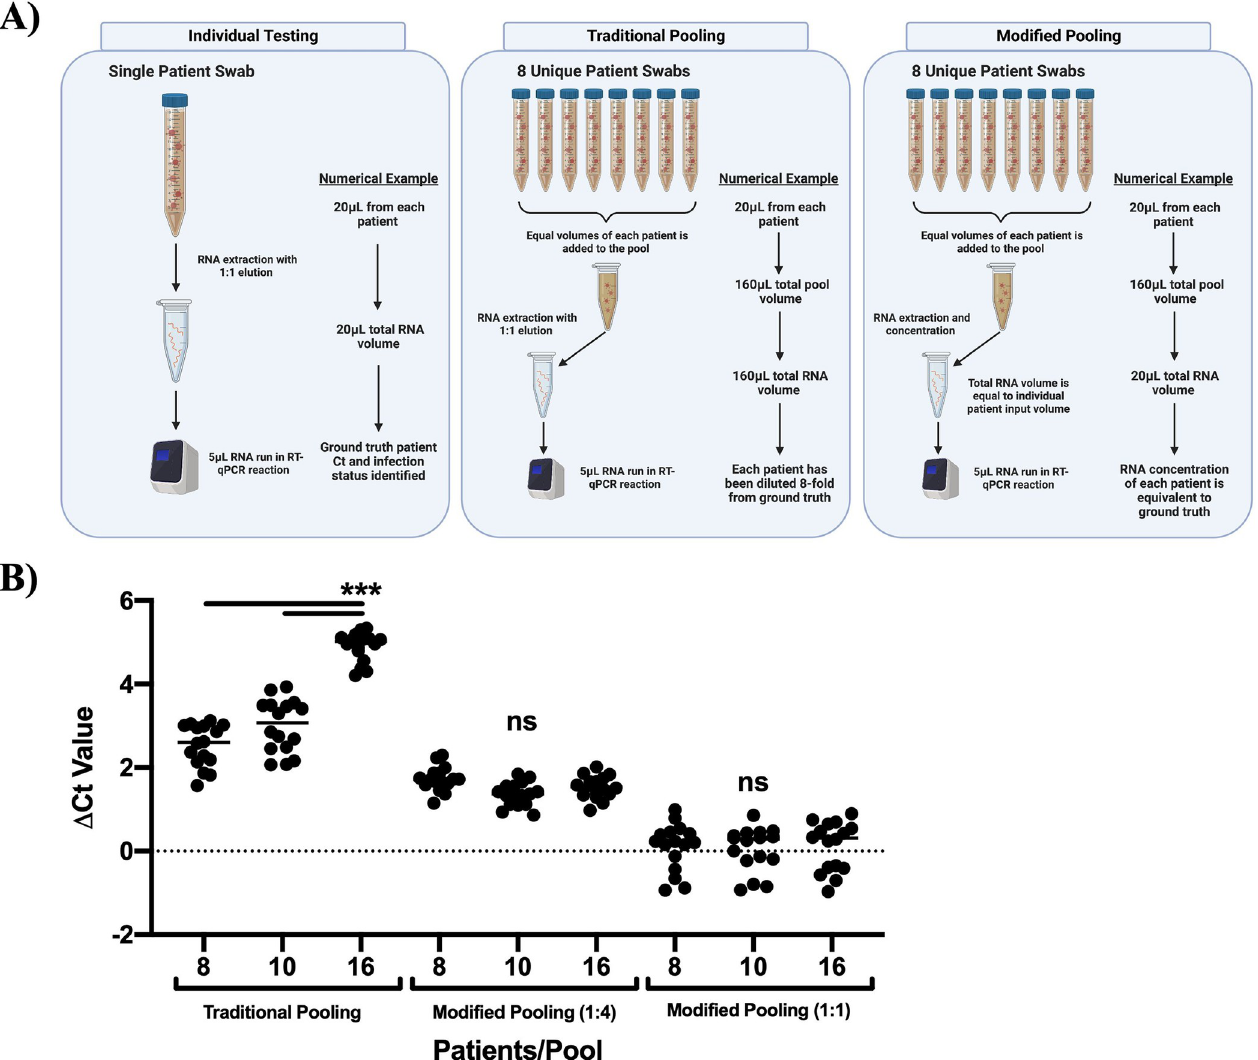
Fig 3. Modified pooling protocol eliminates dilution effect of group testing. (A) RNA extraction and qRT-PCR workflow in individual testing, traditional pooling (group testing), and the modified pooling protocol. Numerical examples are theoretical to display dilution effect and can be scaled to individual diagnostic testing facility protocols. (B) MHV-1 was used to generate individual samples of various viral loads (1x10 9 -1x10 2 copy number/qRT-PCR reaction). qRT-PCR was performed on each sample to develop ground truth Ct values. Samples were then used in various pool sizes in traditional pooling and in the modified pooling protocol. Increases in sample Ct values from the ground truth values were calculated and plotted as Δ Ct Value. Data are presented as the mean ± SEM from two combined independent experiments ( n = 16). For statistical analysis a one-way ANOVA with a Tukey’s post hoc test was performed. ��� p < 0.001, ns = not significant. Created with